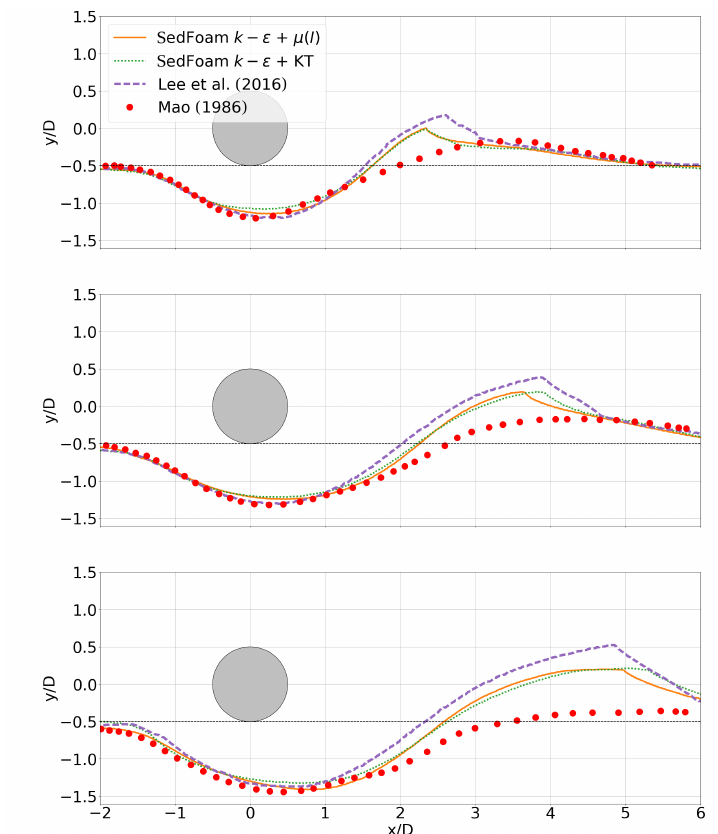
Figure 3. Bed profiles from simulations with the k − ε turbulence model using µ ( I ) rheology (orange line) and kinetic theory (green dotted line) at 11 s (top), 18 s (middle), and 25 s (bottom) compared with experimental data from Mao (1986) [2] (red dots) and numerical data from Lee et al. (2016) [12] (purple dashed